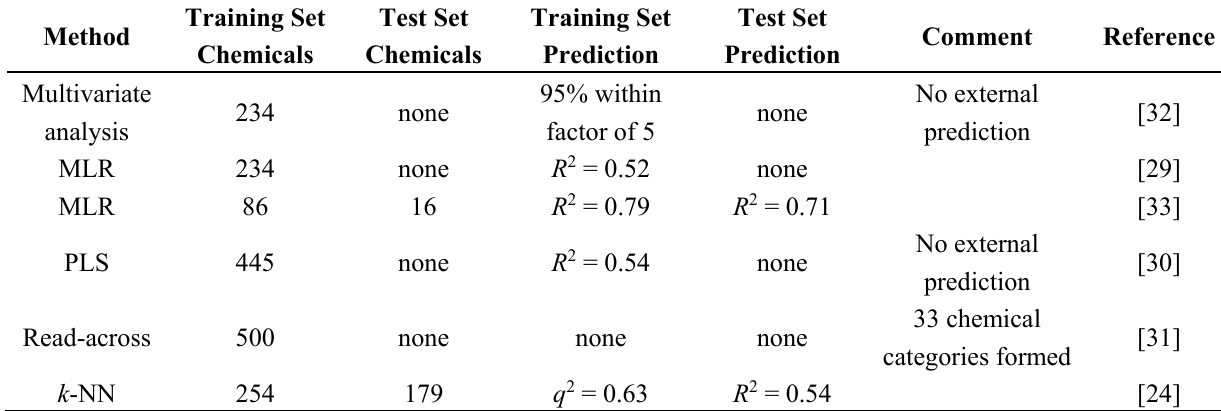
Table 7. Literature survey of QSAR models for prediction of repeated dose toxicity